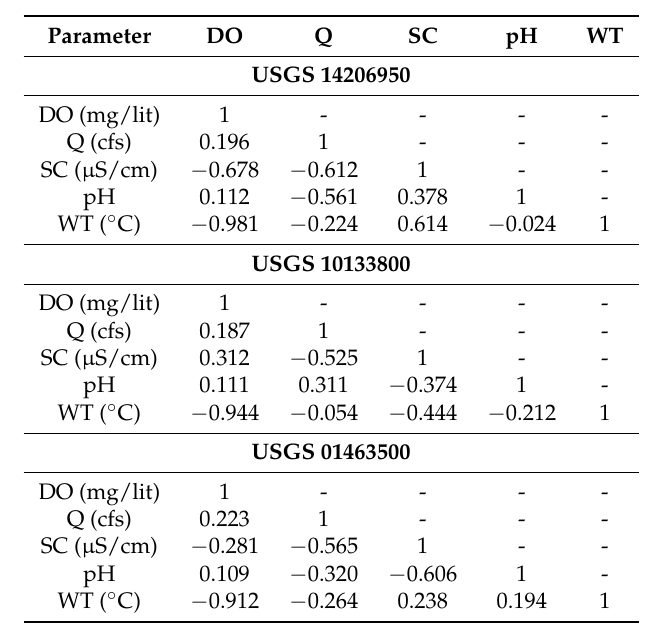
Table 3. The correlation coefficients between DO and other water quality parameters.